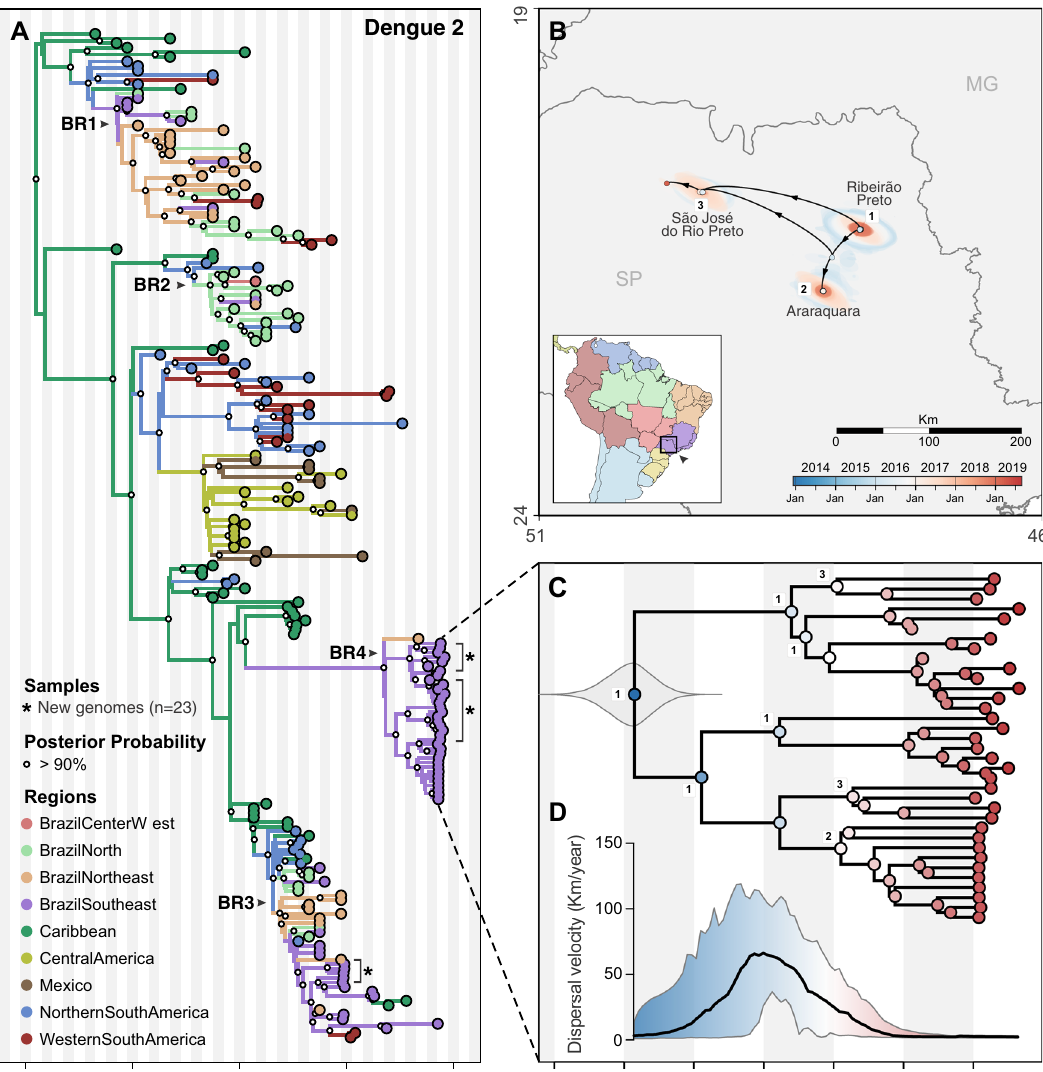
Fig. 6 Regional emergence and cryptic transmission of dengue 2 viruses causing recent outbreaks in Southeast Brazil. A Time-resolved phylogeny of DENV-2 circulating in the Americas since 1987 ( n = 220). Branch colors represent reconstructed ancestral locations using discrete phylogeography. BR1 – BR4 represent lineages of DENV-1, numbered in sequential order based on their dates of introduction in Brazil, as previously described 48,51 . DENV-2 genomes sequenced in this study ( n = 23) are highlighted with asterisks (*). B Continuous phylogeography showing the local spread of DENV-2 in Southeast Brazil, state of São Paulo (SP). Areas numbered as 1 (Ribeirão Preto), 2 (Araraquara), and 3 (São José do Rio Preto) correspond to some of the main locations where DENV-2 circulated in 2018 (see Fig. 2B). Shaded areas represent uncertainties, expressed as the 80% highest posterior density (HPD) of the possible locations of origin of viral ancestors. C Main DENV-2 outbreak clade in ( A ), plotted as movement vectors in ( B ). The violin plot shows the posterior density interval for the TMRCA. Numbers refer to areas shown in ( B ). D Weighted lineage dispersal velocity through time, reaching its peak around January 2016, with mean velocity of 66.2 km/year (con fi dence interval, 31.3 – 103.5